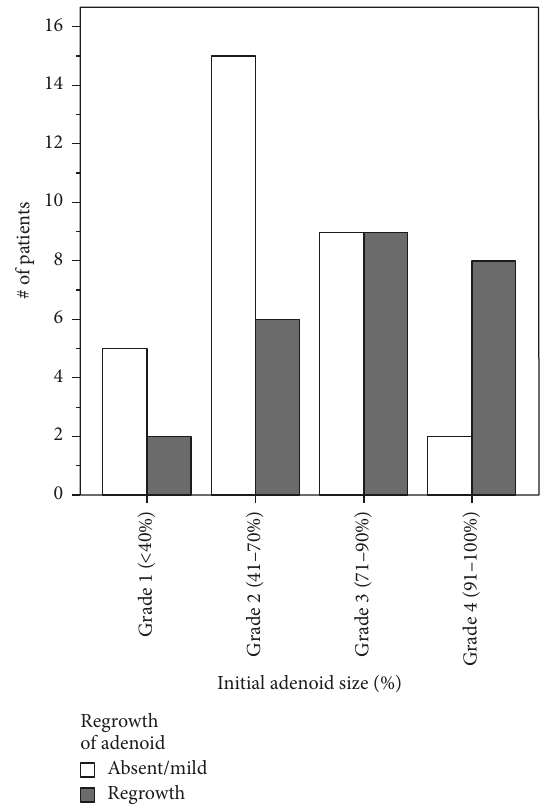
Figure 3: Relationship of body mass index (BMI) for age percentile with incidence of adenoid regrowth ( 𝑃 < 0.05 ).